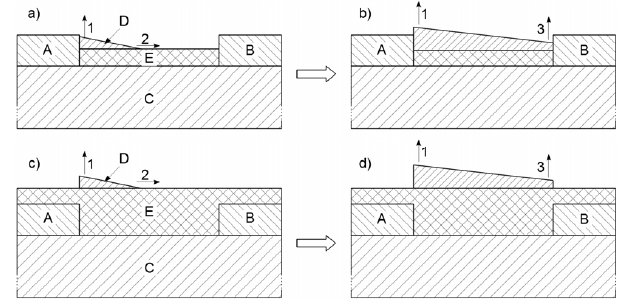
Figure 2. Geometry used for the simulations. The upper row ( a and b ) depicts the setup for a coating (E) being thinner than the electrodes (A) and (B). The lower row ( c and d ) depicts the case of a coating (E) being thicker than the electrodes (coating covers the electrodes). 1, 2 and 3 indicate the growth direction of the soot path (D). C indicates the electrically insulating substrate.